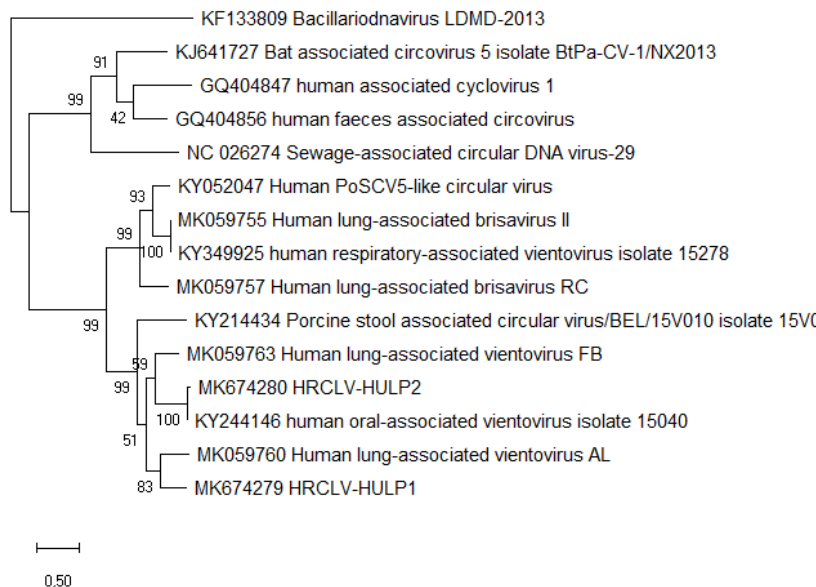
Figure 1. Molecular phylogenetic analyses of the Rep protein sequences of the two sequenced viruses compared with selected sequences from Redondoviridae and other close groups ( Circoviridae , CRESSV2, and Bacilladnaviridae ). The evolutionary history was inferred by using the maximum likelihood method based on the JTT matrix-based model. The tree with the highest log likelihood ( − 9456.60) is shown. The percentage of trees in which the associated taxa clustered together is shown next to the branches. Initial tree(s) for the heuristic search were obtained automatically by applying neighbor-joining and BioNJ algorithms to a matrix of pairwise distances estimated using a JTT model, and then selecting the topology with superior log likelihood value. The tree is drawn to scale, with branch lengths measured in the number of substitutions per site. Evolutionary analyses were conducted in MEGA X [9].